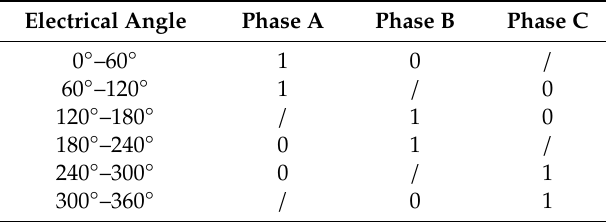
Figure 10. BLDCM control using PWM. Table 3. The relationship between winding sequence and position.